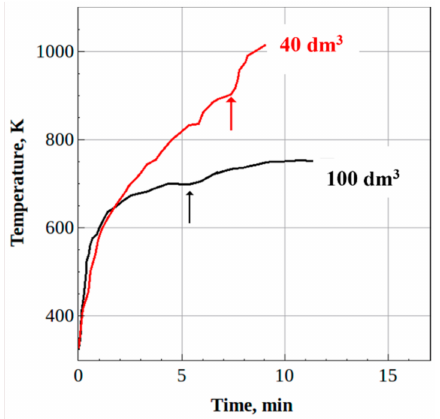
Figure 7. Time histories of syngas temperature in the outlet tube for the 100- and 40-dm 3 reactors with a PD gun operating at f = 1 Hz. Time point 0 corresponds to the start of gasification experiments with the cold reactor loaded by a 2-kg batch of wood